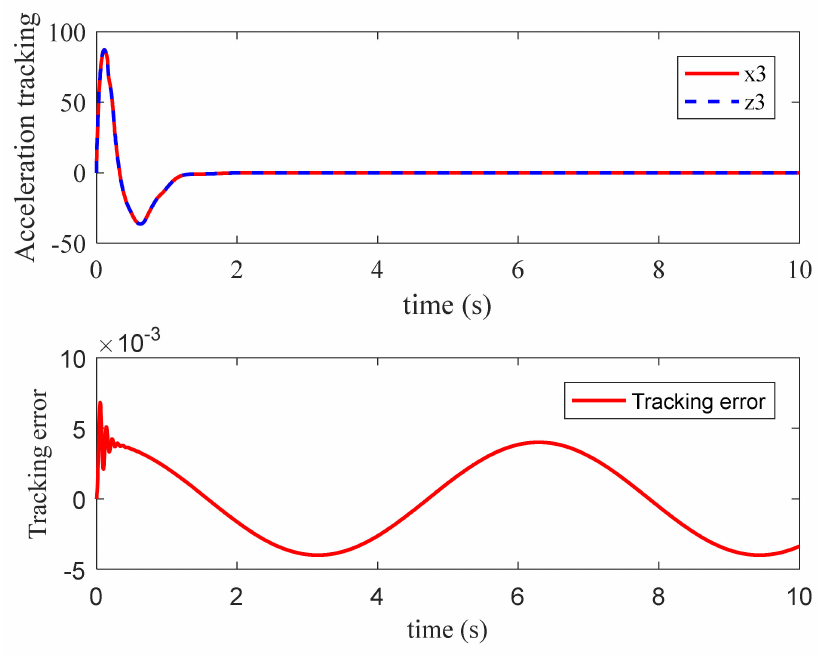
Figure 7. Time response and tracking error of observer for acceleration tracking. ( x 3 and z 3 rep- resent the practical acceleration state of the system and the corresponding state estimated by the observer, respectively).